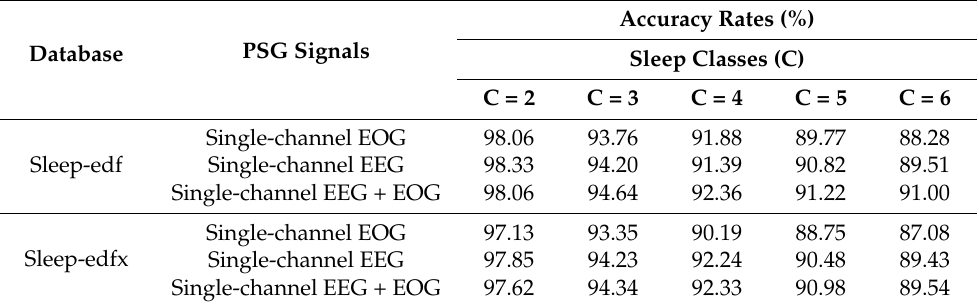
Table 11. Summary of results obtained for various combinations of data used and sleep stages.